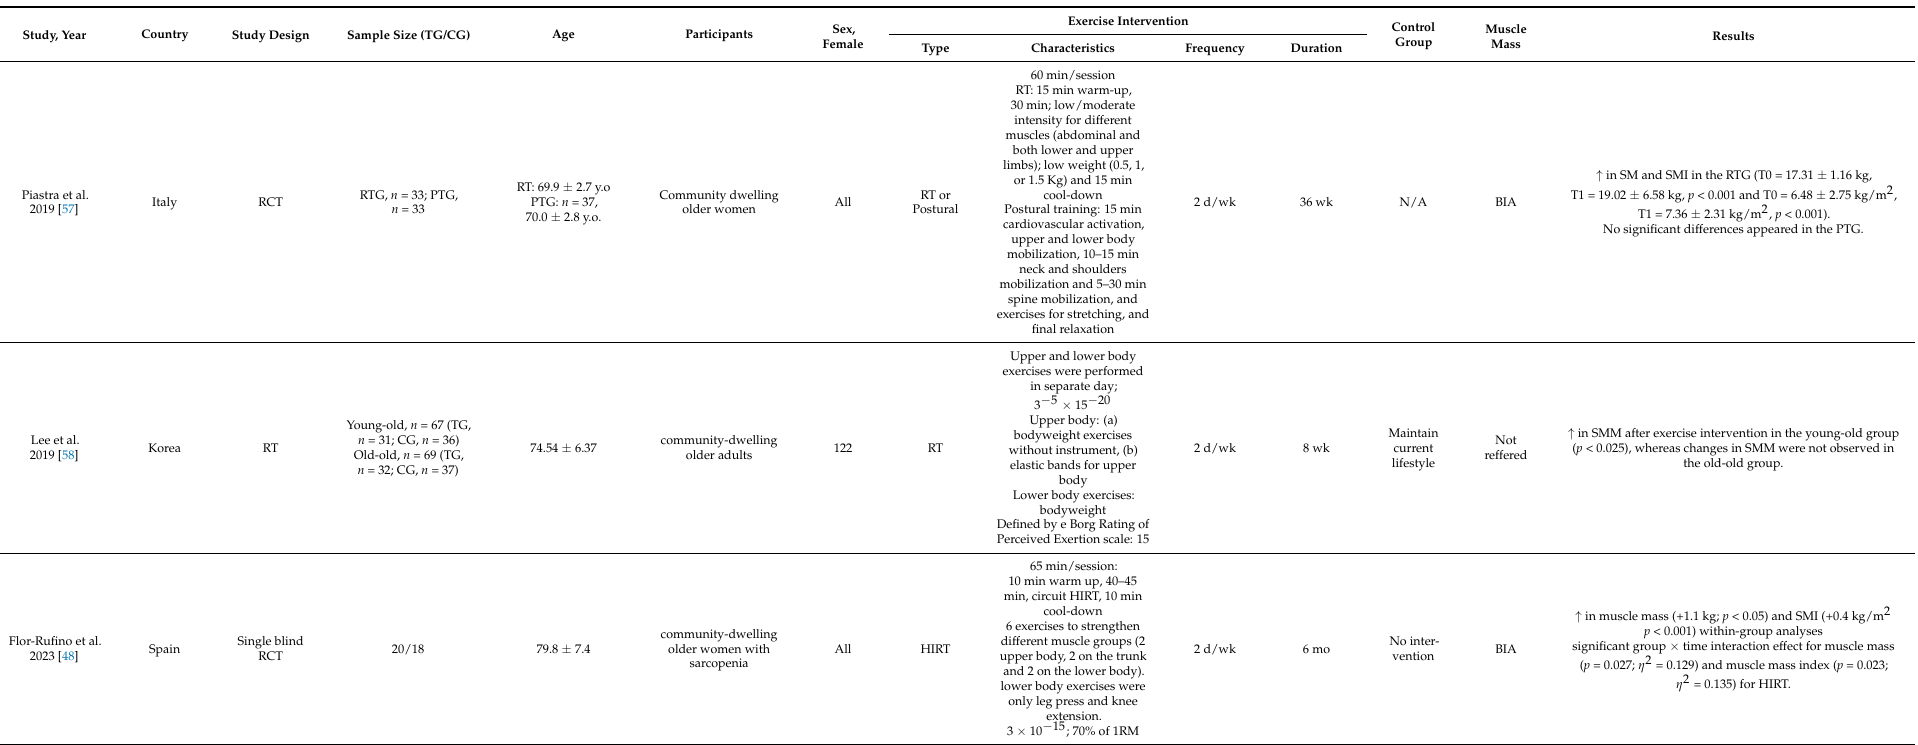
bodyweightexercises withoutinstrument,(b) elasticbandsforupper body Lowerbodyexercises: